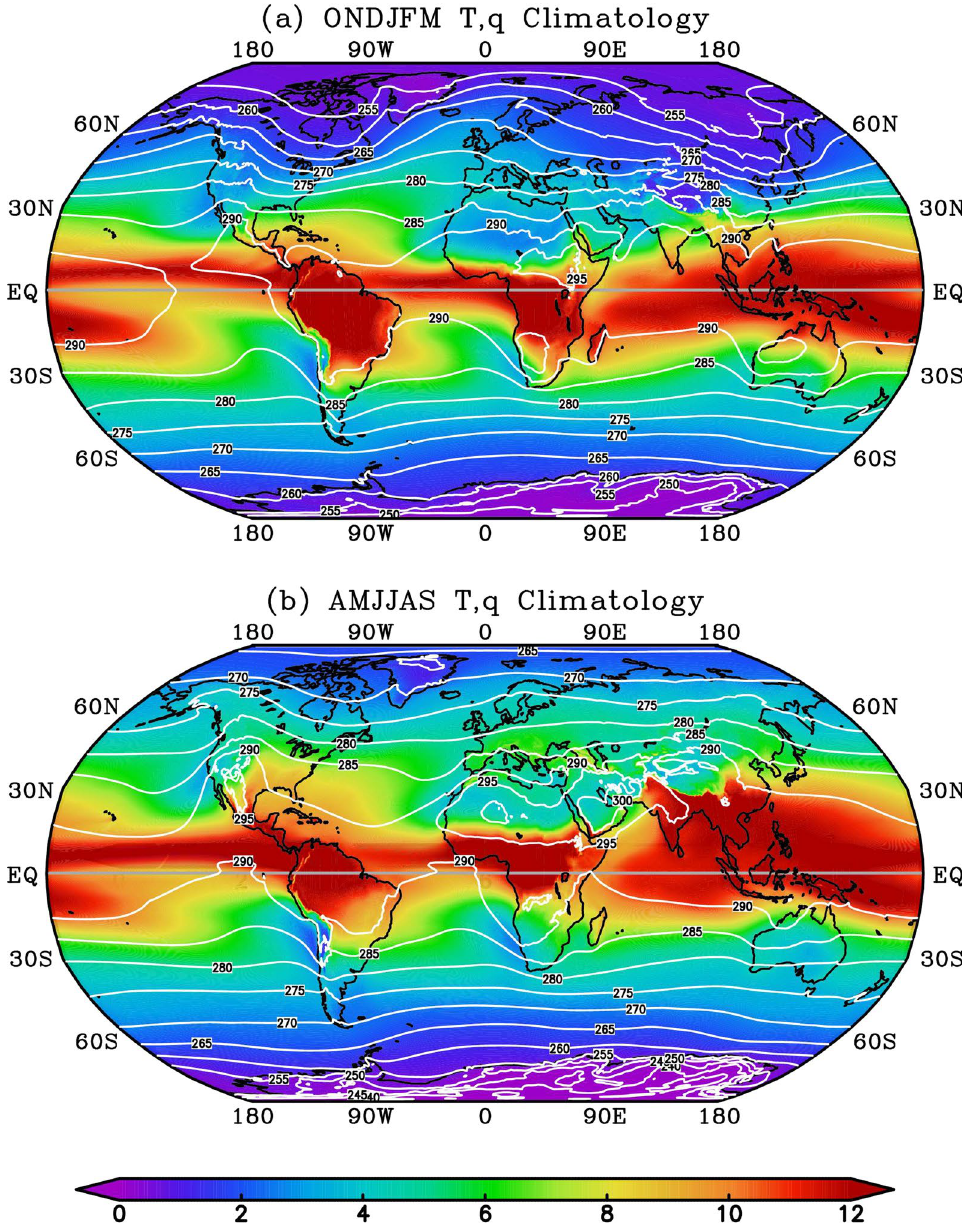
Fig. 2 Vertical mean distributions (925–775 hPa) of the temperature (K; contour) and specific humidity (g kg − 1 ; shading) in the (a) O–M half‑year and (b) A–S half‑year for 1981–2020. The contour interval is 5 K. The scale of shading is shown at the bottom, and the warm and cold colors indicate relatively high and low specific humidity,